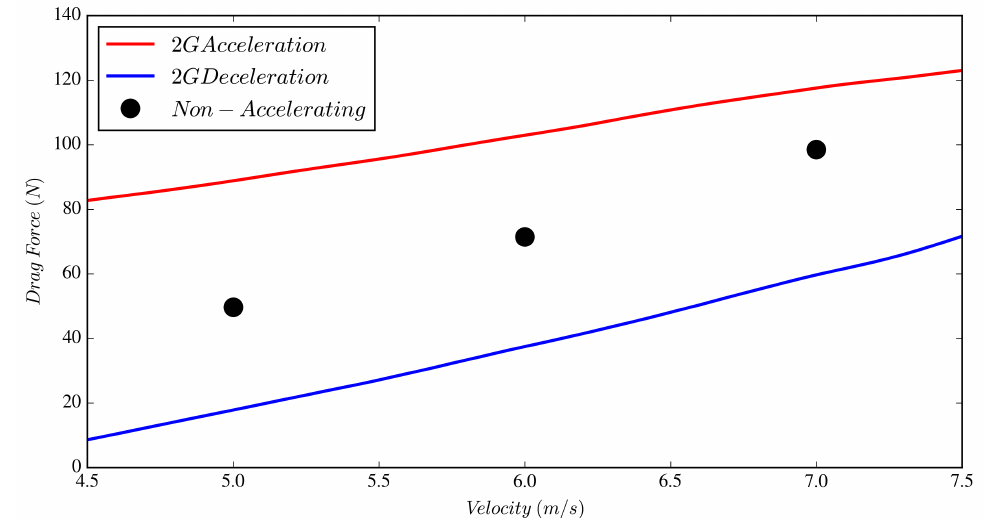
Figure 8. Drag force on the cylinder versus V ref for the decelerating, non-accelerating and accelerating